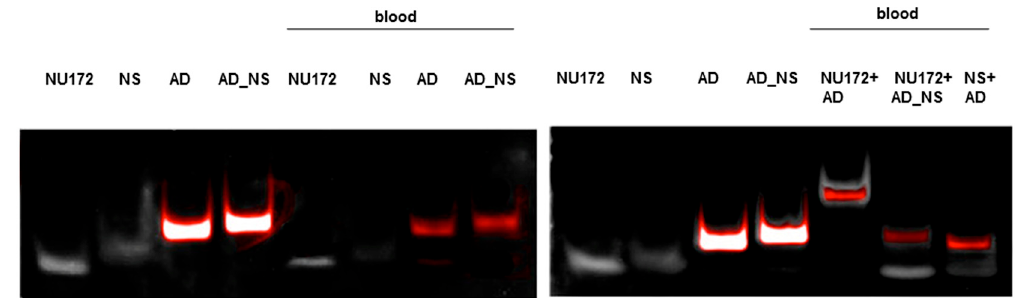
Figure 3. Analyses of the specific binding of the NU172 antidote (AD) to the NU172 aptamer in whole human blood and the formation of aptamer/AD complexes using 10% nondenaturing polyacrylamide gel electrophoresis. Blood was first incubated for 2 min with 5 µ g NU172. Subsequently, 5 µ g NU172 (AD) was added and incubated for 2 min. After isolation of oligonucleotides, samples of 10 µ L were analyzed. NS and AD_NS were used as negative controls. Firstly, FAM-labeled ADs were detected using an UV-transilluminator (red colored bands) and then all oligonucleotides were detected using GelRed™ staining (white colored bands). An overlay of FAM and GelRed staining is presented. NS: NU172 (NS), AD: NU172 (AD) FAM, AD_NS: NU172 (AD_NS) FAM.